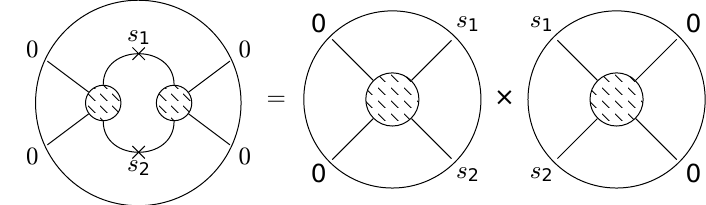
Figure 1 . The double cut in one-loop Witten diagram for the scattering of four scalar fields in the HSGRA is expressed in terms of tree-level on-shell amplitudes. The shaded blobs indicate the sum off all tree-level